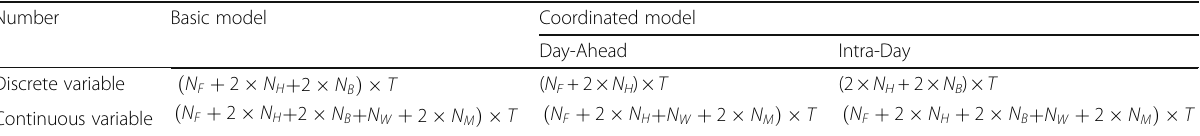
Table 2 Comparison of the variable number of basic and coordinated dispatch models Number Basic model